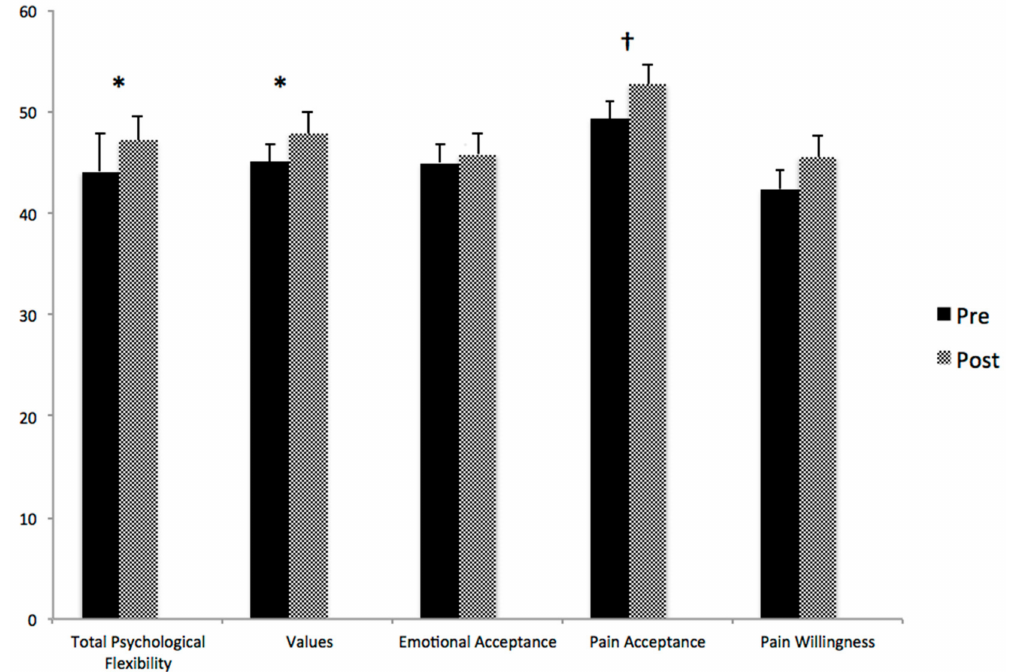
Figure 1. Parent Psychological Flexibility Questionnaire (PPFQ) scores pre and post workshop. * p < 0.05, † p <